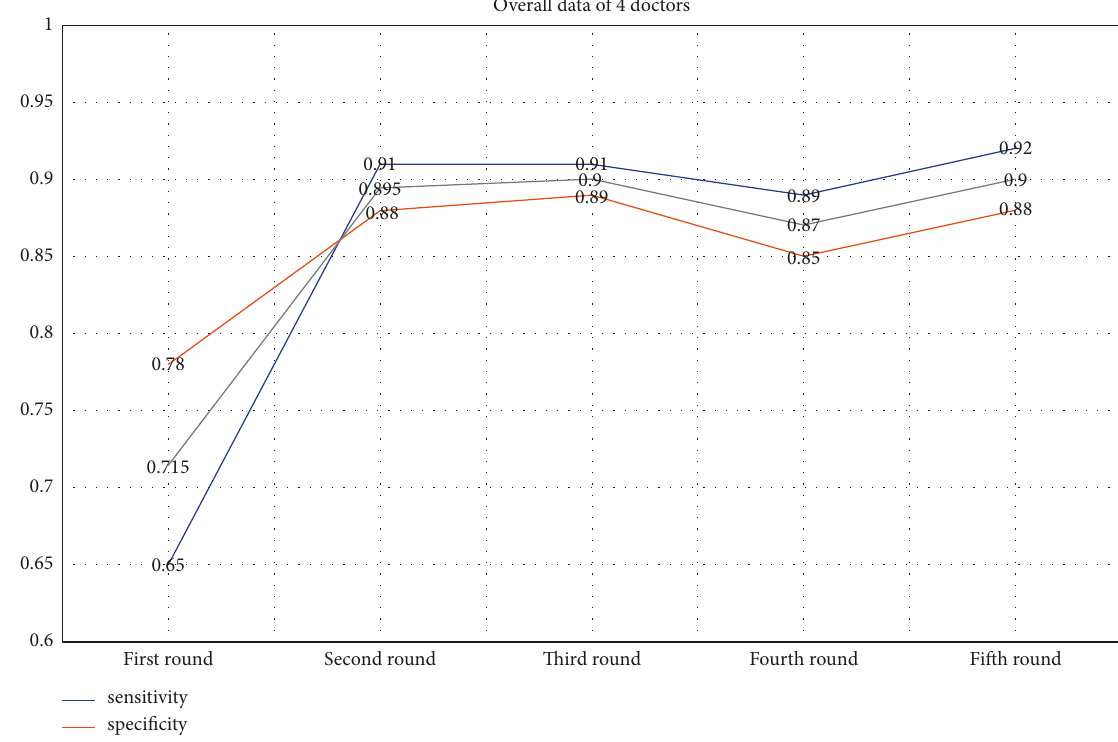
Figure 4: The overall sensitivity, specificity, and accuracy of doctors were greatly improved with the help of AI, and the change trend was consistent. Especially in the third round, the overall accuracy of doctors reached that of AI. Due to the strict requirements for doctors as a whole, this achievement was very commendable. In the fourth and fifth rounds, it could be seen that doctors with low accuracy combined with AI could significantly improve the overall diagnostic accuracy of